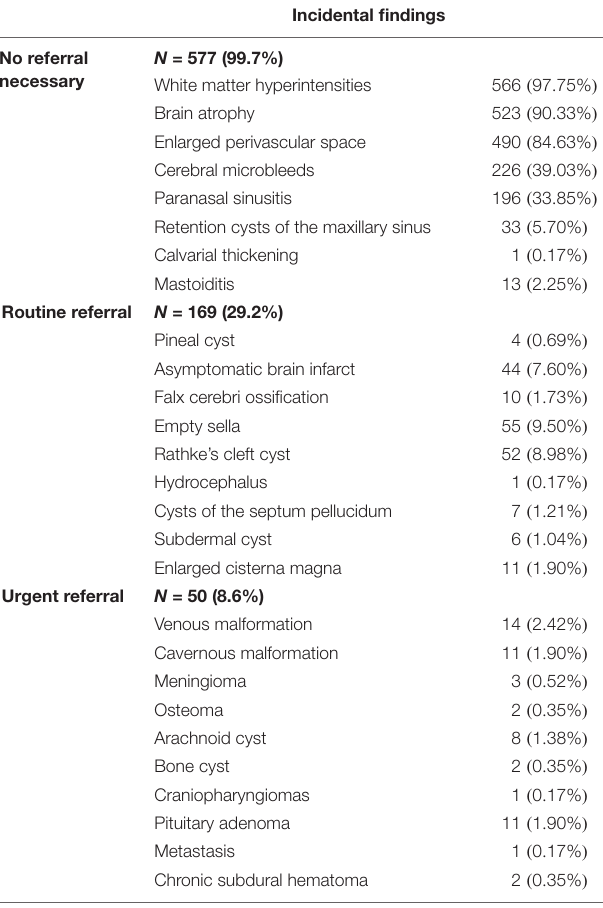
TABLE 4 | Detection rate of each incidental